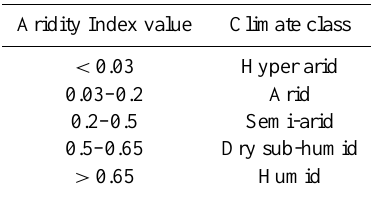
Table 2. Generalized climate classification scheme for Global- Aridity values (UNEP, 1997).